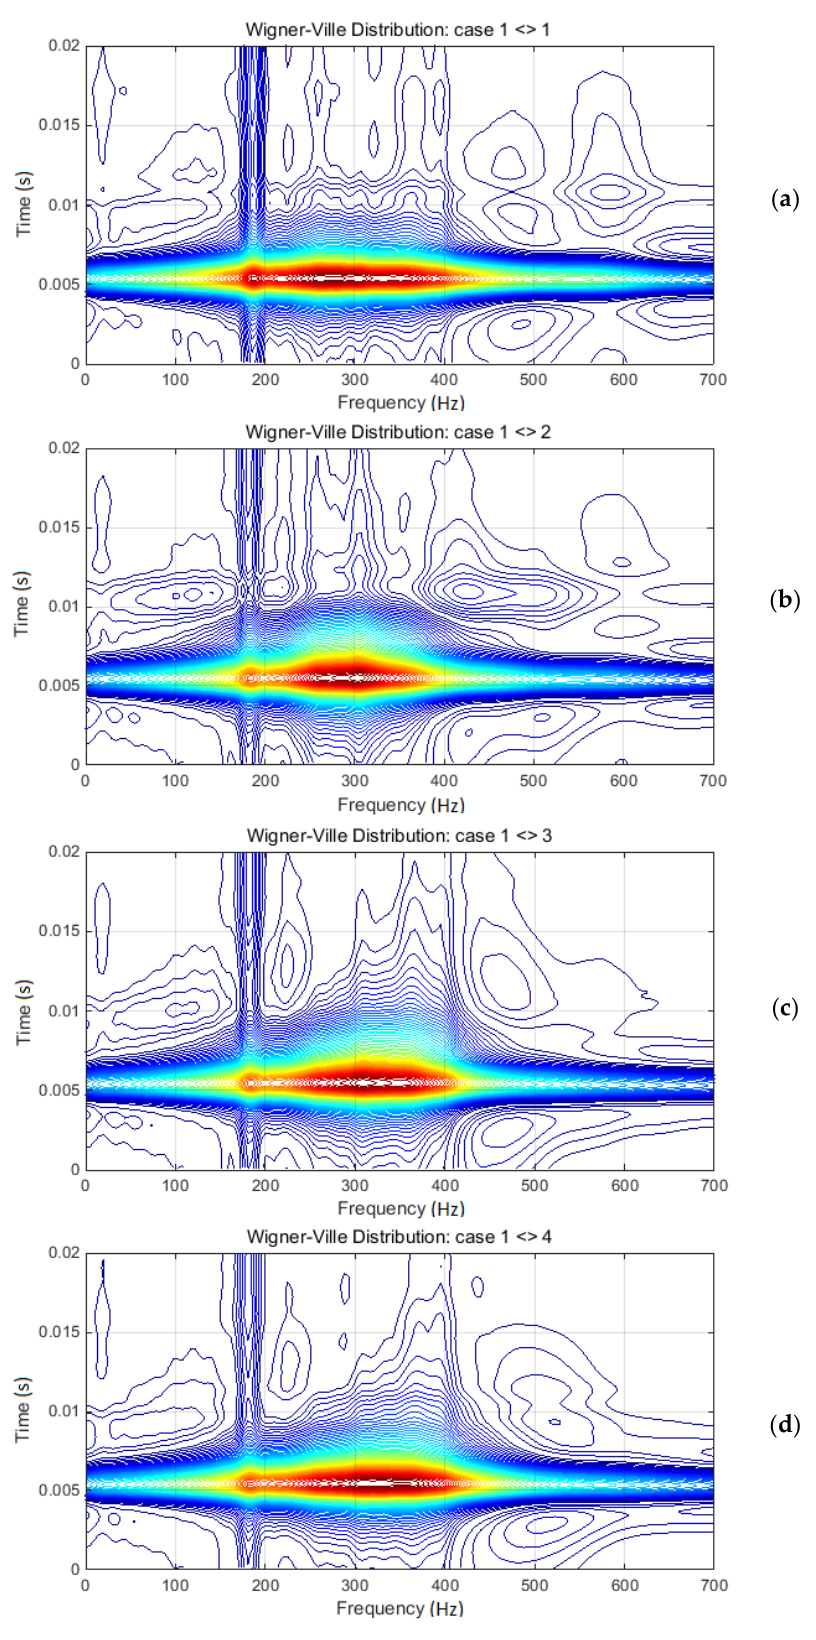
Figure 11. Cross-WVD diagrams: ( a ) Case 1 related itself; ( b ) Case 2 related to Case 1; ( c ) Case 3 related to Case 1; and ( d ) Case 4 related to Case 1. Diagrams are focused on time–frequency relevant domain.